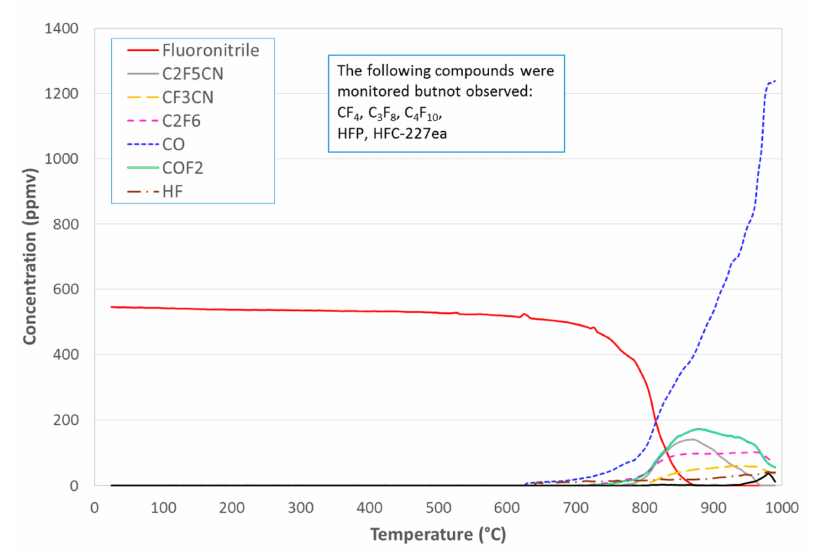
Figure 10. Degradation byproducts and thermal stability of the dielectric fluid (CF 3 ) 2 CFCN analyzed by infrared spectroscopy (FTIR) [50].